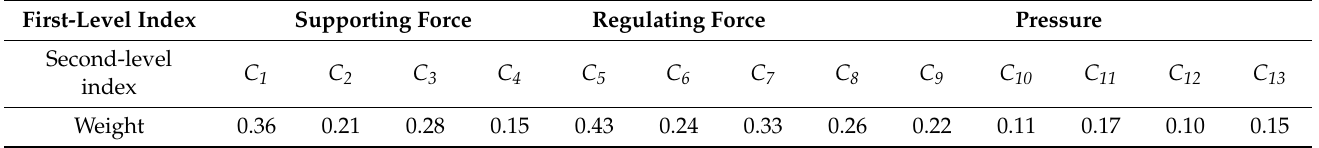
Table 4. Weight table of vulnerability indicators for the vulnerability of